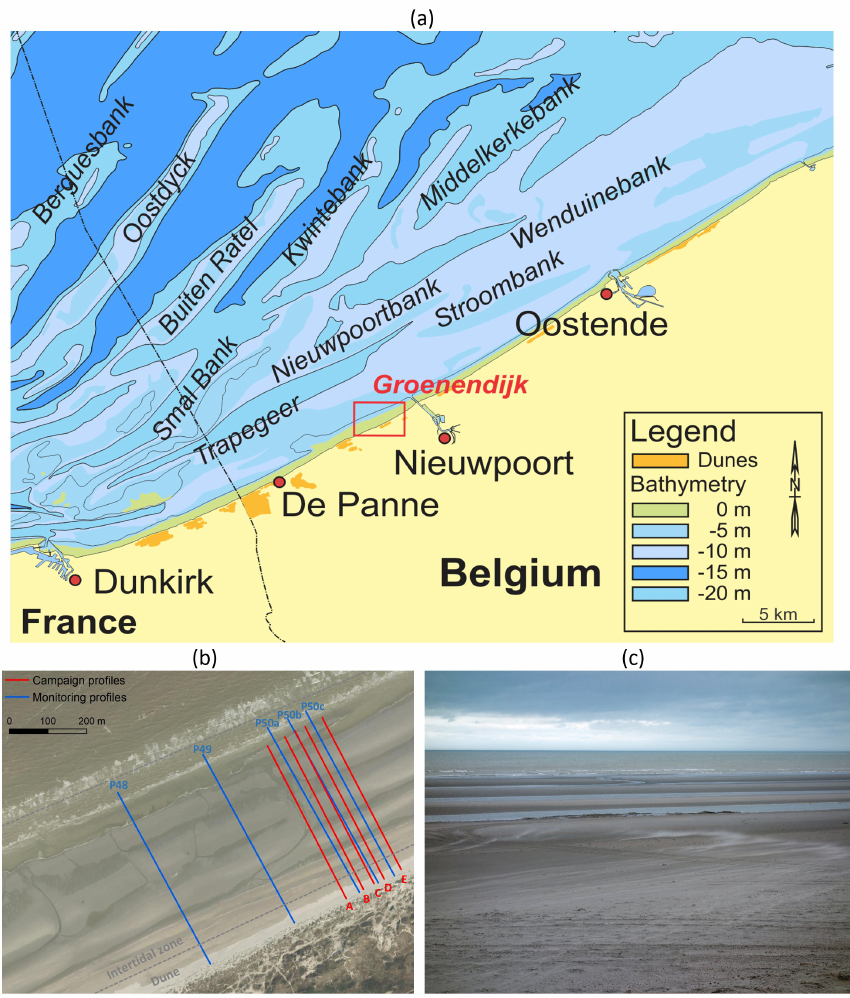
Figure 1. Location of study site and cross-shore profiles. ( a ) Study site position on the Belgian Coast. ( b ) Continuous monitoring profiles (in blue), campaign profiles (in red), intertidal zone (between dashed lines). ( c ) Photo of the Groenendijk beach showing the intertidal bars.